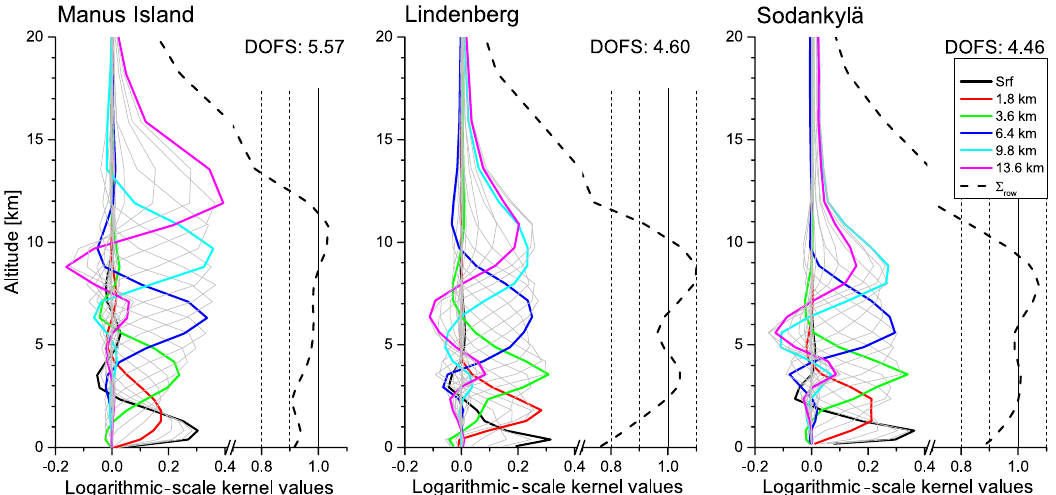
Figure 3. Example row kernels ( A 11 + A 12 ; see Eq. 11) for the three reference sites. Manus Island: 28 November 2013 11:37:24UT, satellite zenith angle 12.4 ◦ , precipitable water vapour 46.4mm; Lindenberg: 8 October 2008 20:00:38UT, 16.3 ◦ , 14.1mm; Sodankylä: 24 August 2007 08:31:25UT, 27.8 ◦ , 13.7mm. Numbers in the upper right corners of every panel indicate the respective degrees of freedom for signal (DOFS). Row kernels of selected altitudes are highlighted by thick coloured lines. The thick black dashed line represents the sum along the row of the averaging kernel matrix.